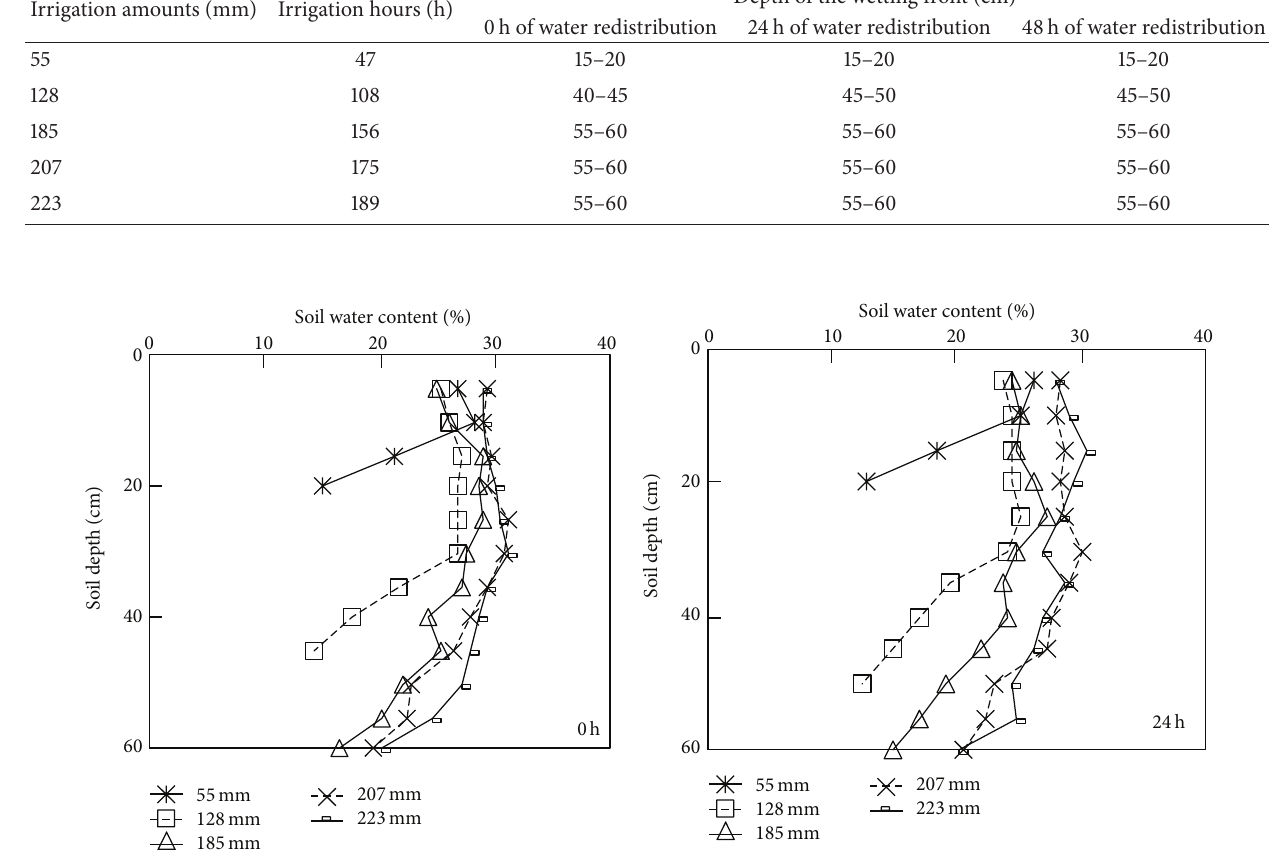
Table 2: Period of irrigation and depth of the wetting front at 0, 24, and 48 h during redistribution for each irrigation amount. Irrigation amounts (mm) Irrigation hours (h)